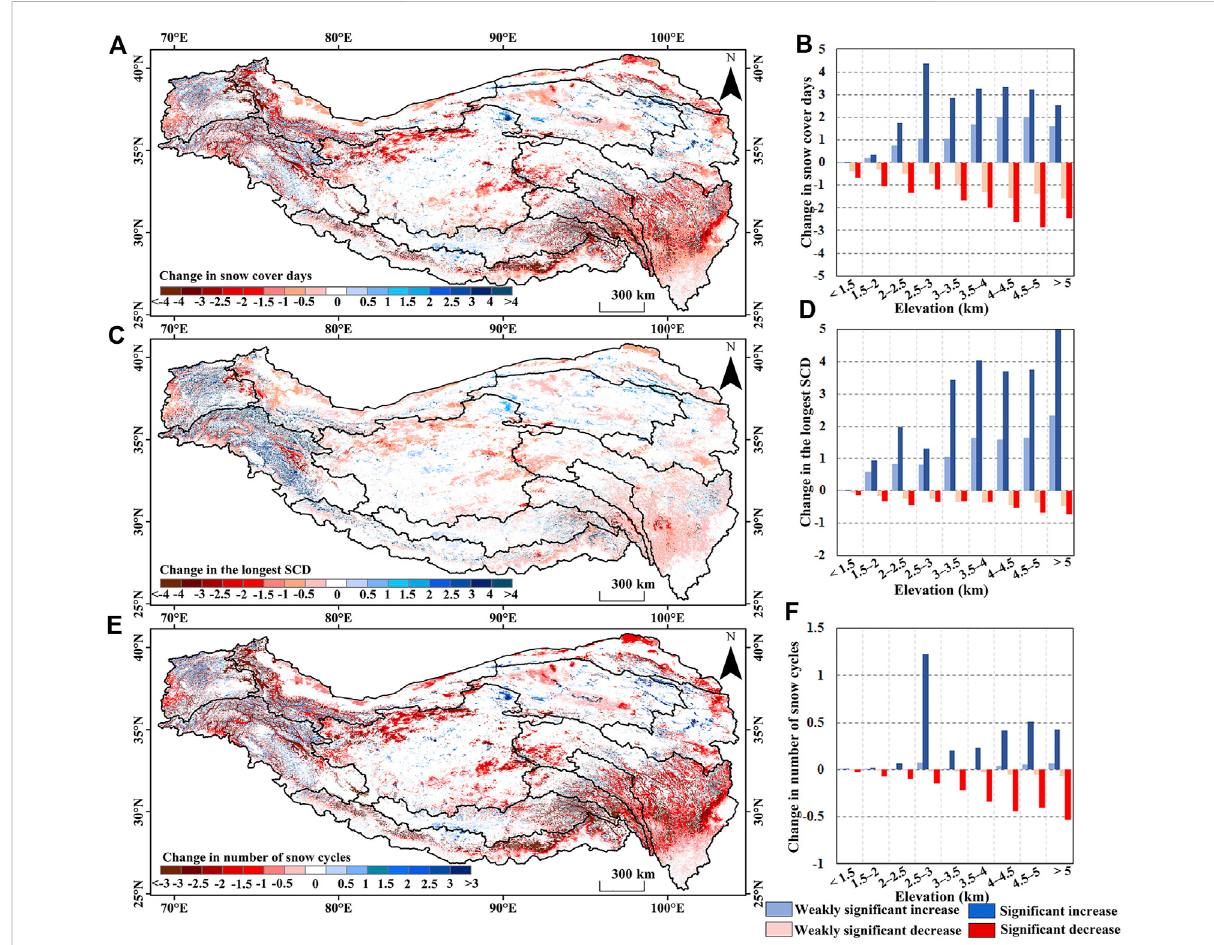
FIGURE 7 Changes in snow cover days (A) , longest SCD (C) , number of snow cycles, (E) and corresponding values in different elevation zones (B,D,F)